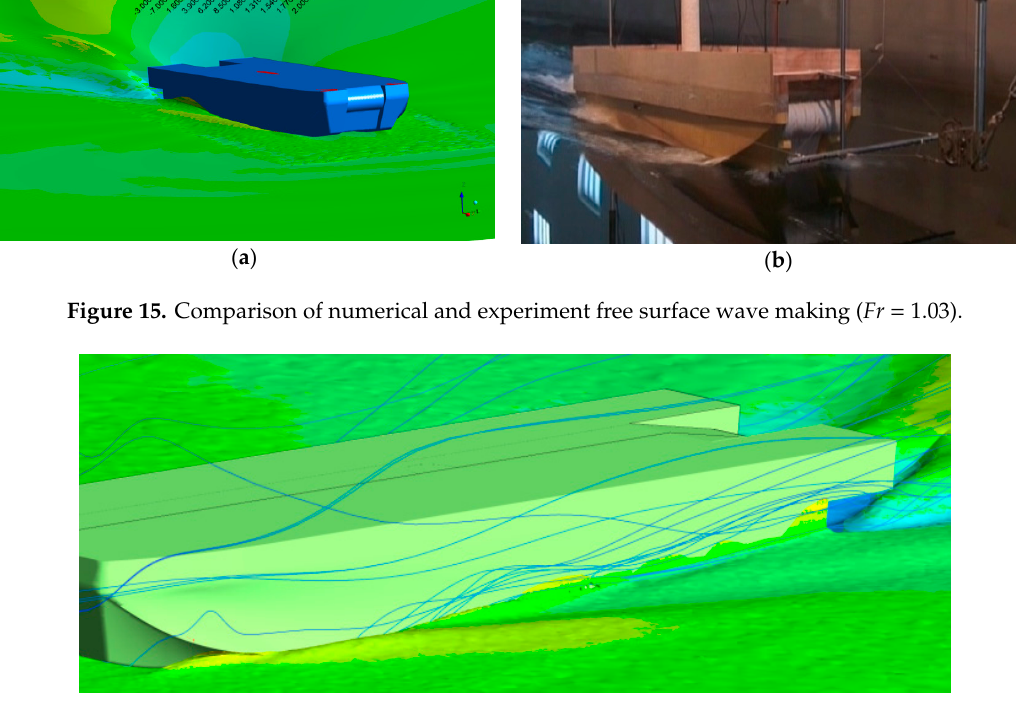
Figure 16. Air leaks from the demihull side.